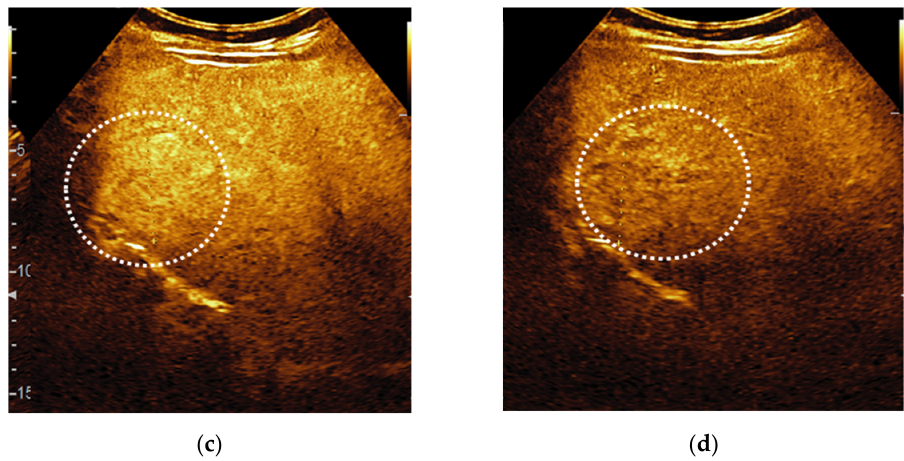
Figure 8. LI-RADS-4 liver lesion, probably HCC. B-mode ultrasound shows an inhomogeneous liver nodule ( a ). After intravenous administration of contrast agent, an arterial phase hyperenhancement (APHE) is observed ( b ). No washout is noticed in the portal ( c ) or in the late phase ( d ). There were 29 lesions classified by using CEUS as probably or definitely malignant but not HCC specific (LR-M); 13 of them (44.8%) were HCC, 3 of them (10.3%) were ICC, 3 (10.3%) mixed tumor HCC/ICC and 10 (34.4%) metastases (Figure 9).